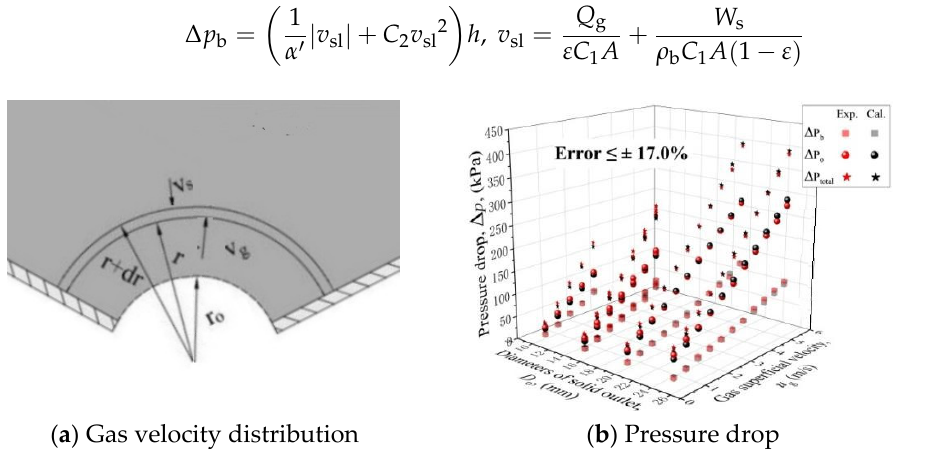
Figure 12. Gas velocity distribution near the solid outlets in the bed with cone structure and the comparison of experimental and theoretical pressure drop results.